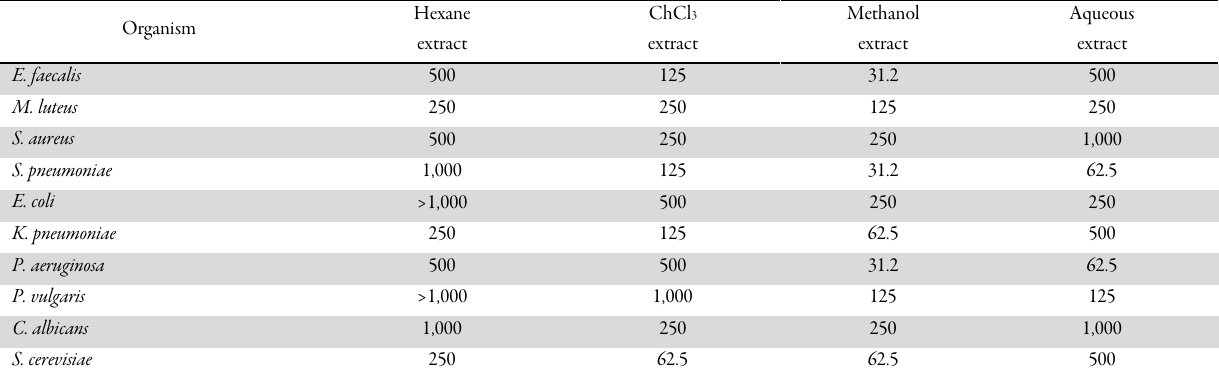
Table 3. MIC values of Litsea glutinosa leaf extracts against the tested microorganisms